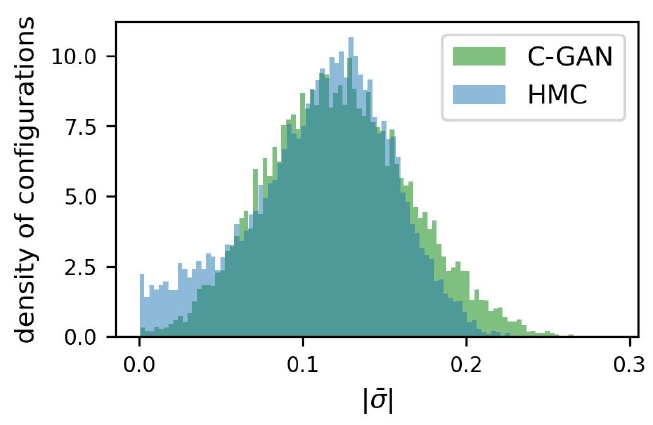
Figure 16: Histogram of | ¯ σ | at λ = 1.6 ∈ Λ ts quite